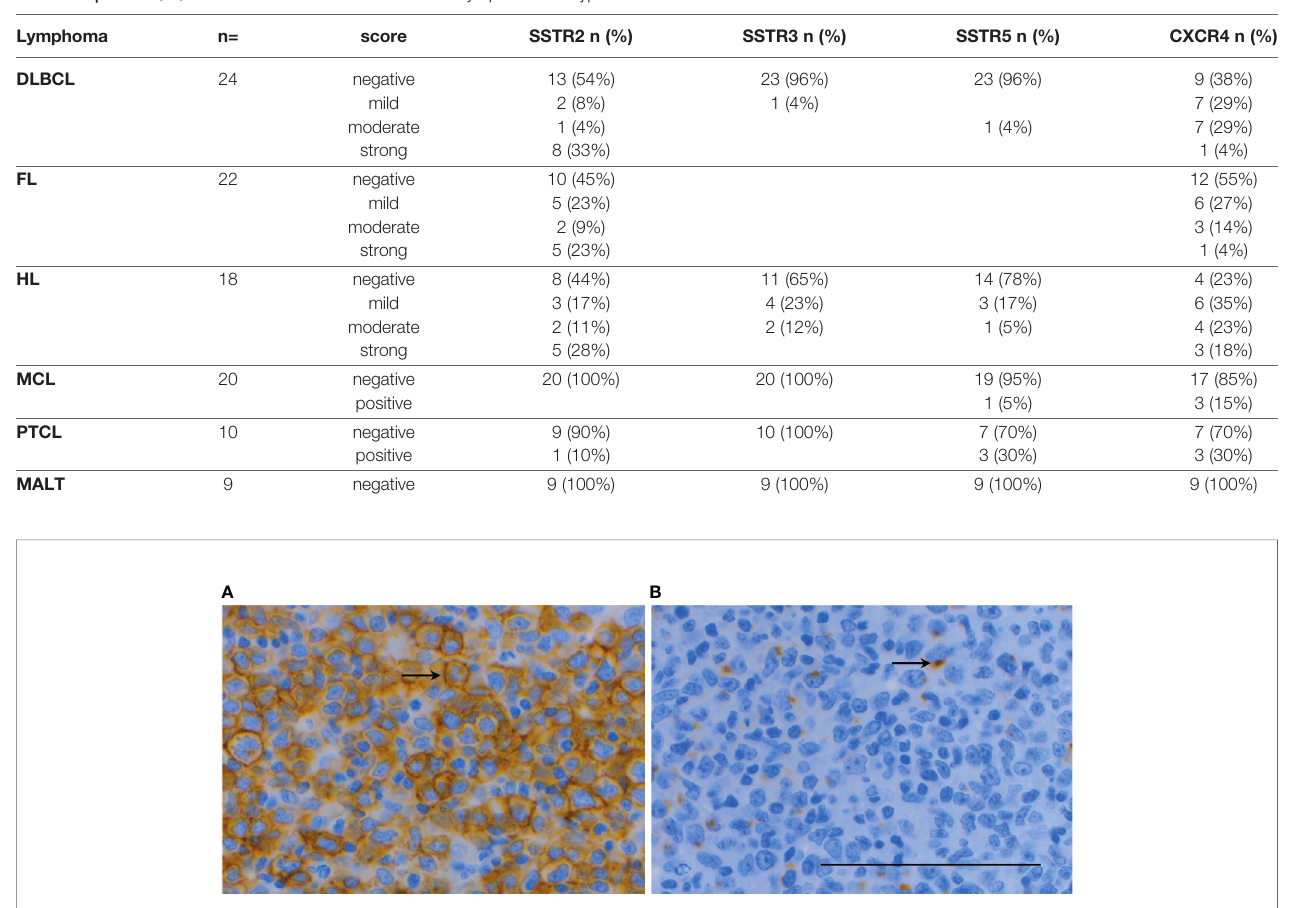
TABLE 3 | SSTR2, 3, 5 and CXCR4 IHC results in studied lymphoma subtypes. Lymphoma